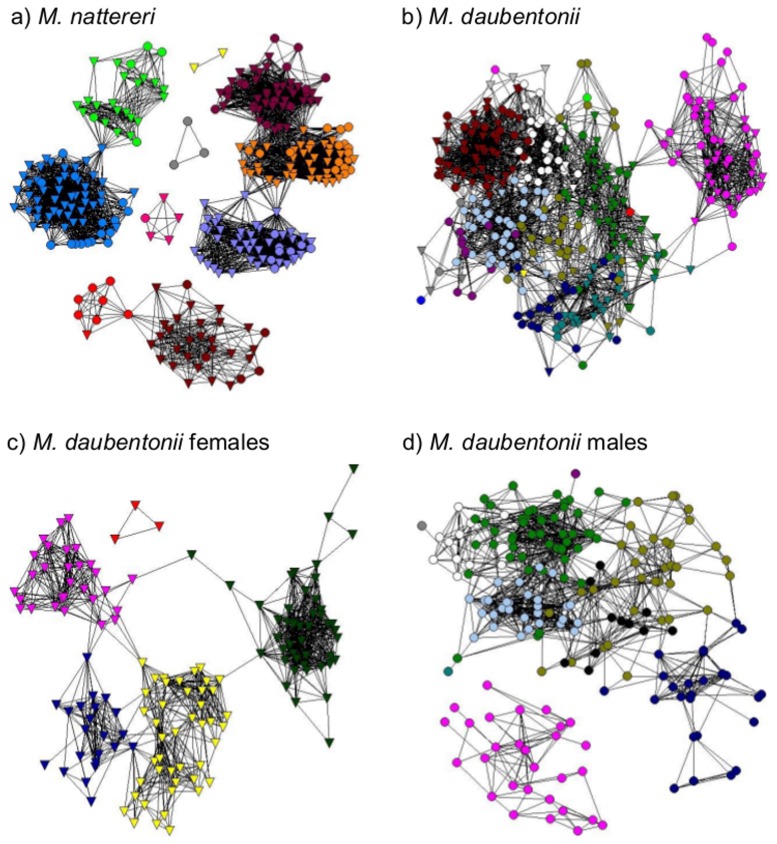
Social network visualisation a) male and female M. nattereri, b) male and female M. daubentonii, c) female M. daubentonii, and d) male M. daubentonii.
a) M. nattereri male (n = 85) and female (n = 214), modularity  = 0.74, b) M. daubentonii (n = 344), modularity  = 0.66, c) female M. daubentonii (n = 145), modularity  = 0.67, d) male M. daubentonii (n = 199), modularity  = 0.64. Nodes represent individual bats (males, circles; females, triangles) and associations are represented by the lines that join them. Colours indicate the assignment of individuals to social groups using the Girvan-Newman algorithm. Colours do not correspond between panels. Colours in a) and c) are comparable to Figure 3. The position of individuals within these networks indicates their position in social space and is not an indication of an individual's geographical location.